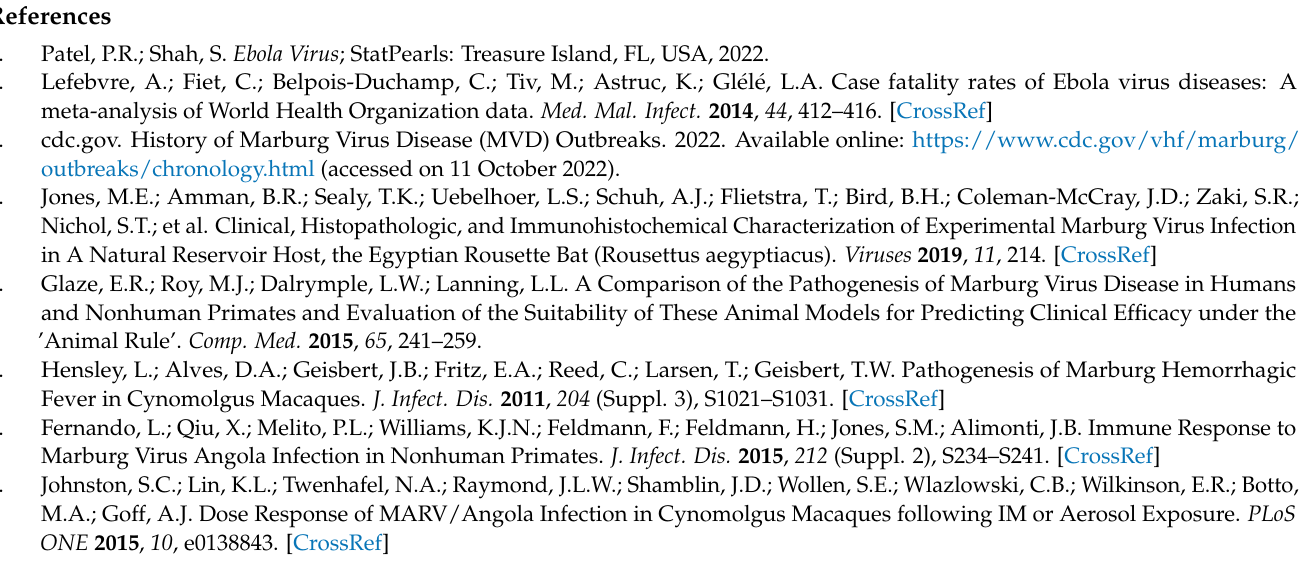
Figure S2. Hematological Changes over Time; Table S1. NHP Clinical Scoring Criteria; Table S2. MARV Natural History Study: Individual Animal Data; Table S3. Historical Overview of Nonhuman Primate Controls Challenged with Marburg Virus: Time to Death; Table S4. Clinical Scoring for MARV-exposed NHPs; Table S5. Clinical Scoring for Mock-exposed NHPs; Table S6. Incidence Summary of Microscopic Observations in Mock-exposed and MARV-exposed